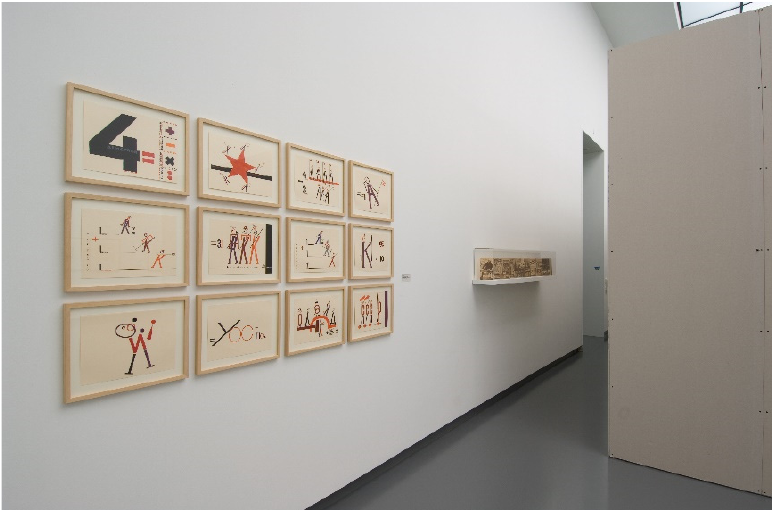
Figure 14. View of some of the works in the corridor of the presentation ‘Plug In #06: El Lissitzky, Deimantas Narkevicius’, Van Abbemuseum, 2006. Front: El Lissitzky, ‘Die vier Grundrechnungsarten’ (‘The Four Basic Calculation Types’), 1928 (reprint 1976). Collection Van Abbemuseum. Back: El Lissitzky, ‘Catalogue of the Pressa Exhibition’, Cologne 1928. Van Abbemuseum. Photo: Peter Cox.